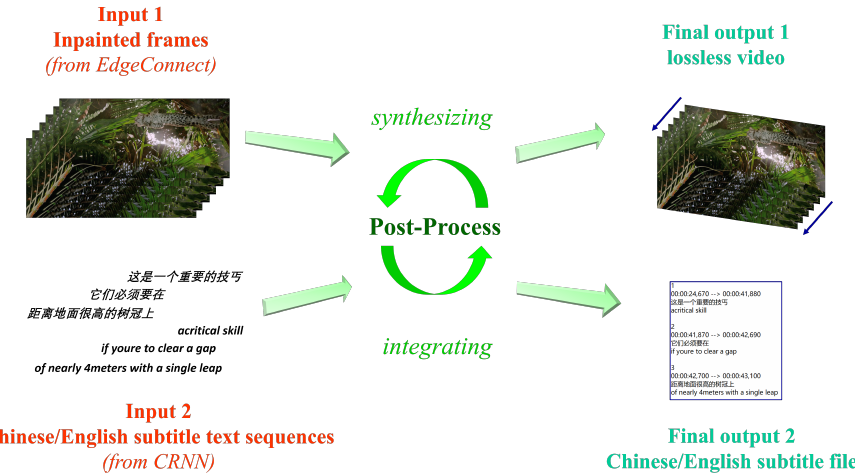
Figure 8. The inpainted frames and Chinese/English subtitle text sequences to Chinese/English subtitle file and subtitle-free video via